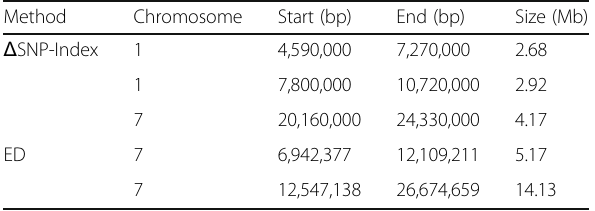
Table 1 Distribution of salt-tolerant region on chromosomes detected by Δ SNP-index and ED algorithms